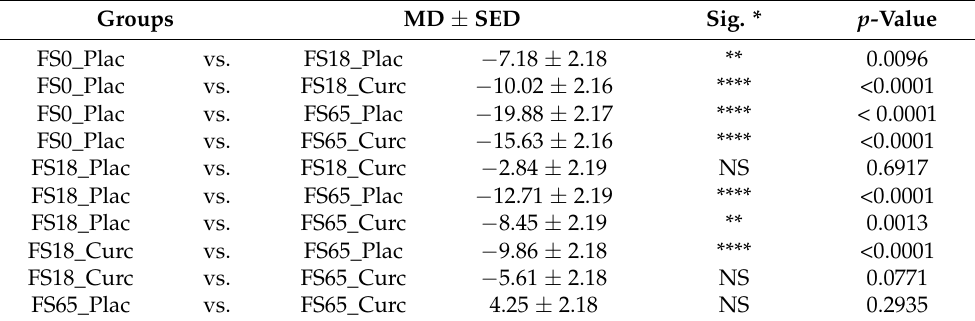
Table 2. Inter-group differences in serum iron levels (µmol/L) at 180 min.